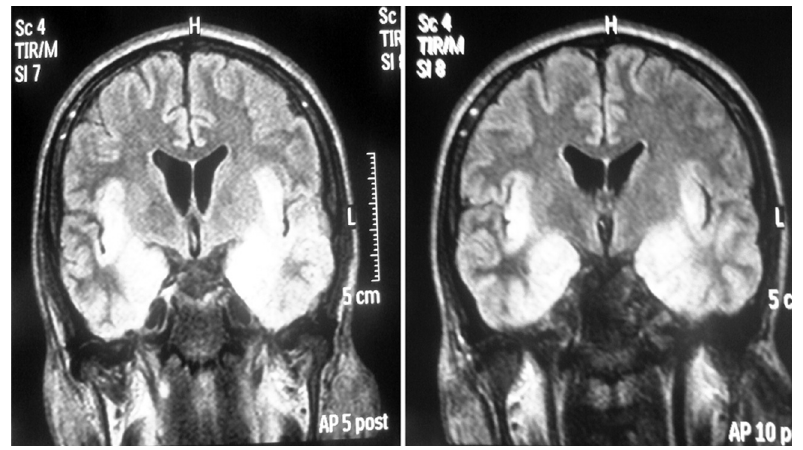
Figure 1. Hypersignal in flair acquisition on MRI in bilateral temporal lobes, extending to insula